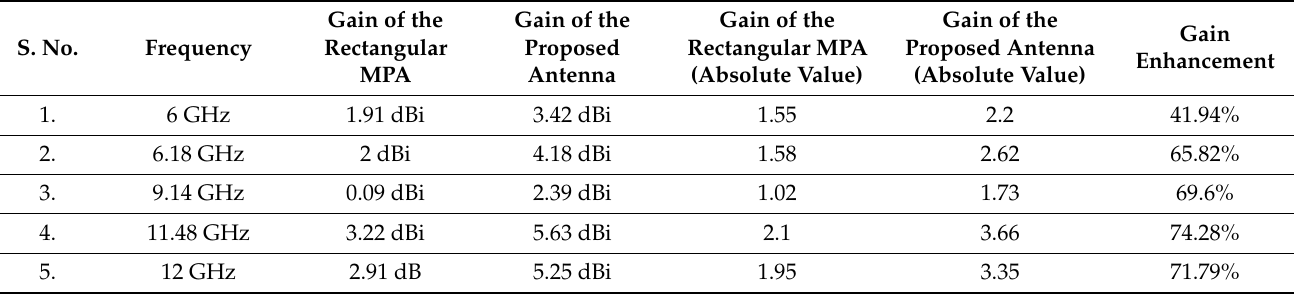
Table 5. Realized gain of the rectangular MPA and the proposed